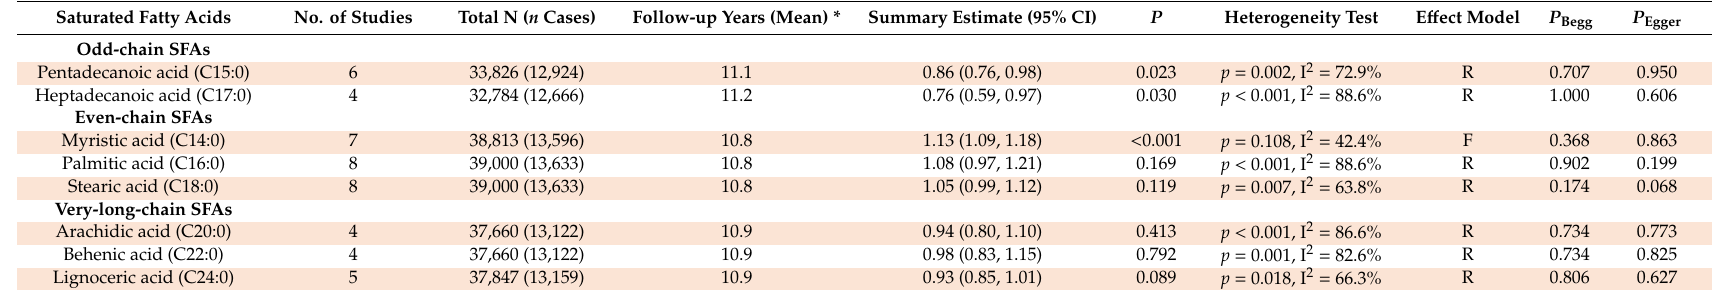
Table 3. Main meta-analyses result of the relationship between individual SFAs and T2D (per SD di ff